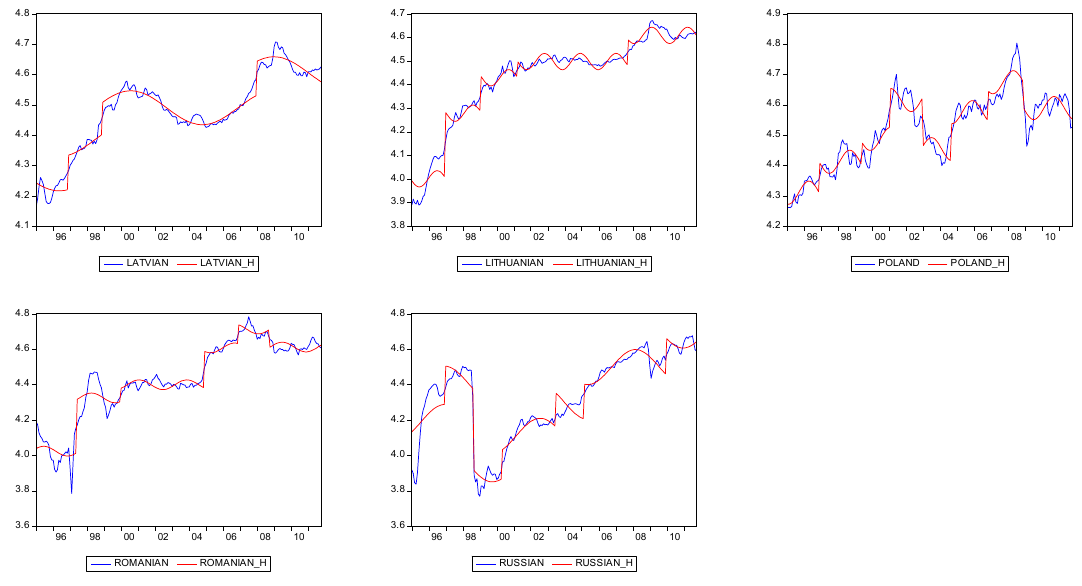
Figure 1. Time series plot of real exchange rates (in log form) for eight transition countries and the fitted nonlinear flexible intercept with sharp shifts and smooth